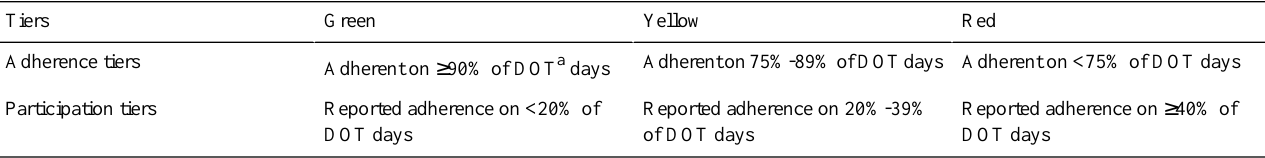
Table 1. Directly observed therapy adherence tiers for program participation monitoring.